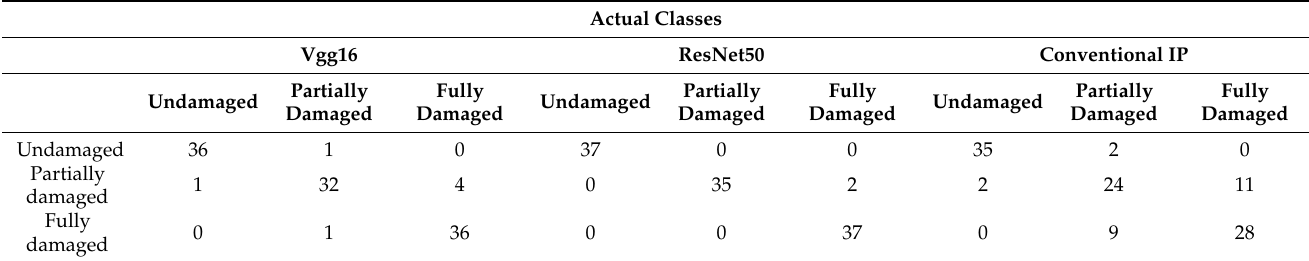
Table 4. The Values of confusion matrix of DNNs and conventional image processing for classification of dam-aged rapeseed crop for test set.